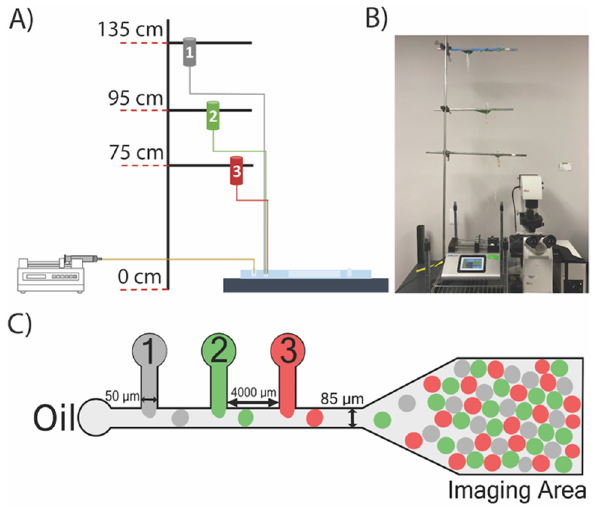
Figure 1. Microfluidic Device Design and Operation. ( A ) Schematic of the developed gravity- driven platform where reservoirs at different heights were used to initiate the flow in the aqueous inlets. A syringe pump was used for oil inlet; ( B ) photograph of the developed droplet microfluidics platform including the gravity flow/syringe pumps, and the device mounted on the Leica Microscope; ( C ) the schematic of the droplet microfluidics system showing different parts of the device during a TA experiment.